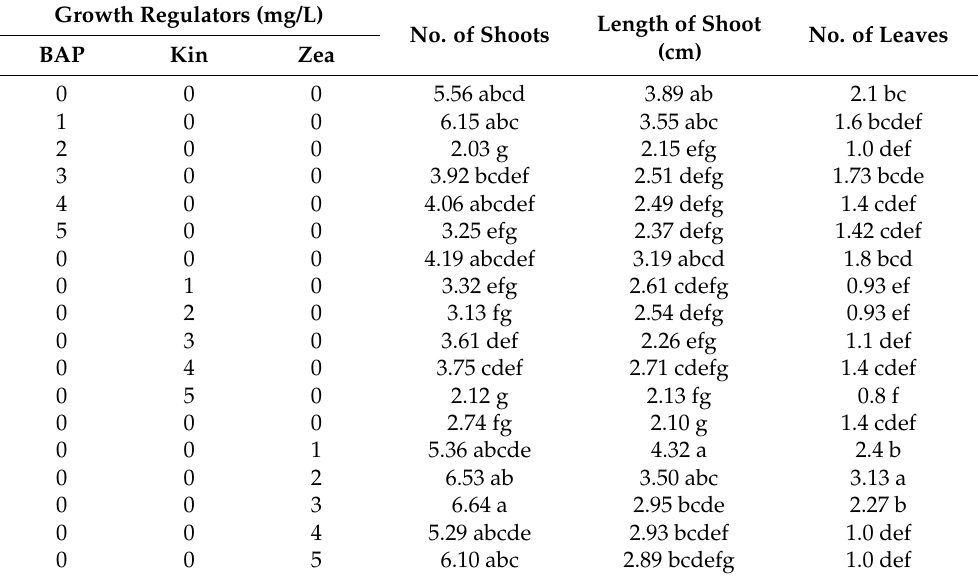
Table 1. The effects of BAP, kinetin, and zeatin on shoot multiplication from nodal segment of Labisia pumila var. alata after 6 weeks of culture. Growth Regulators (mg/L)